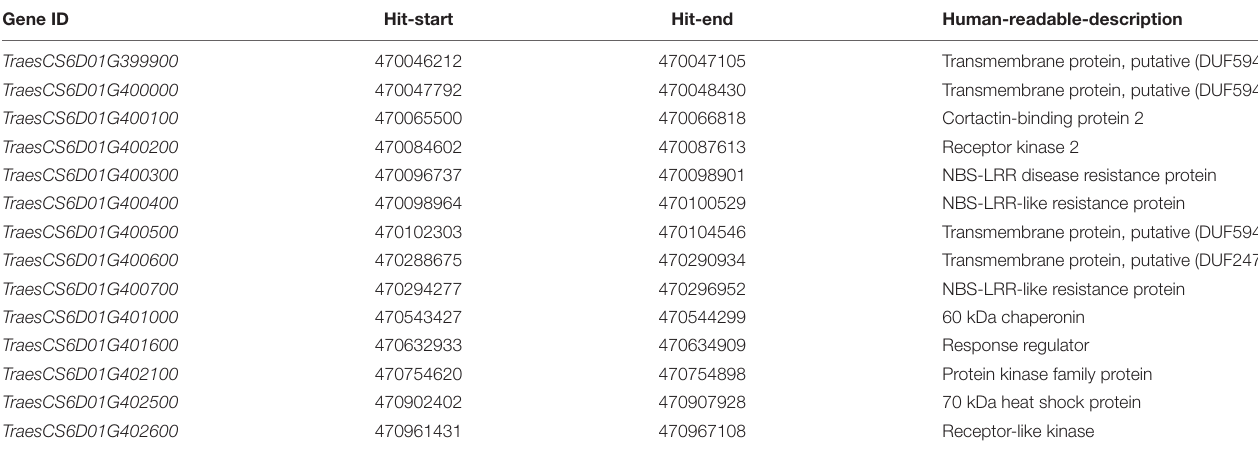
TABLE 3 | List of candidate genes in the closest flanking markers 1082100 and 1228999 and gene annotations based on Chinese Spring IWGSC RefSeq